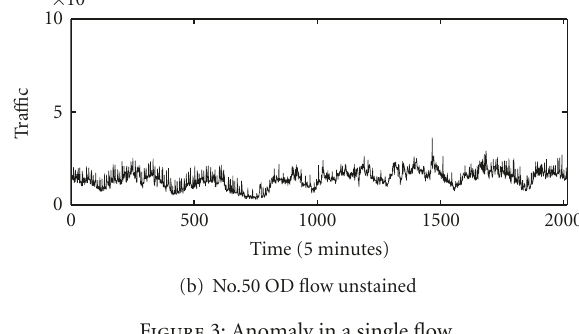
Figure 3: Anomaly in a single flow.